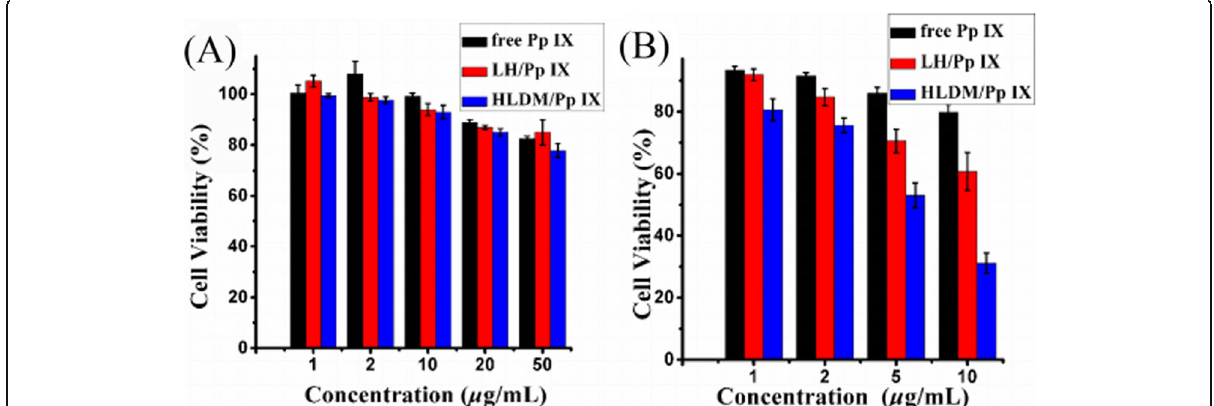
Fig. 8 a MCF-7 cells viability of free Pp IX, Pp IX-loaded LH micelles, or Pp IX-loaded HLDM micelles under light condition. b Relative light-toxicity